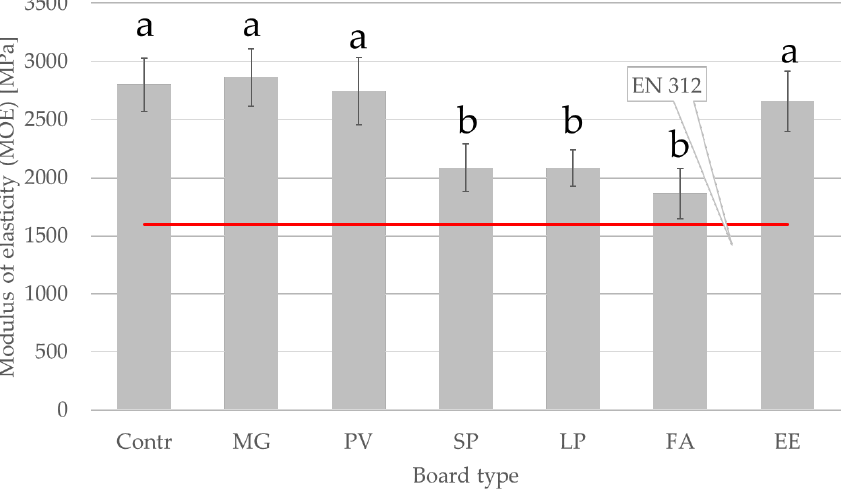
Figure 3. Modulus of elasticity of manufactured panels. Abbreviations used: contr.—control (100% wood); FA— Festuca arundinacea , EE— Elymus elongatus , LP— Lolium perenne , MG— Miscanthus x giganteus , PV— Panicum virgatum , SP— Spartina pectinate. Different letters indicate the presence of statistically significant differences at p < 0.05 according to one-way ANOVA and Tukey test.